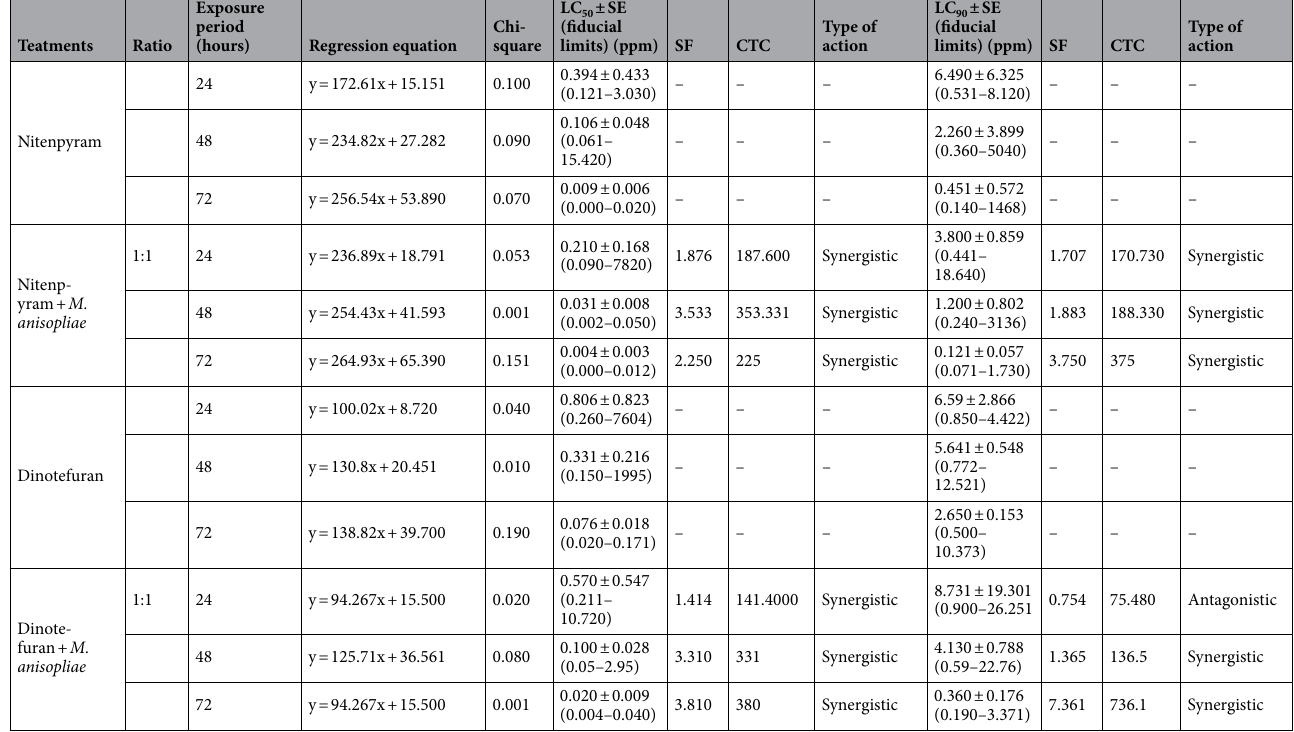
Table 3. Toxicity of insecticides (Nitenpyram and Dinotefuran) with and without M. anisopliae for A. gossypii. CTC co-toxicity coefficient, SF synergy factor.